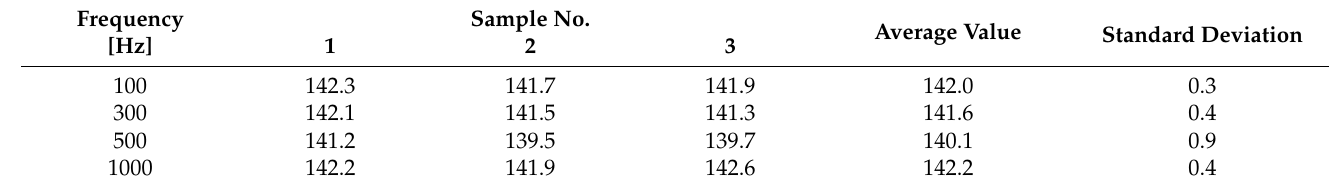
Table 10. Dynamic stiffness (dB re. 1 N/m) for PSMA8 poroelastic layer with SMA11 as binder course—laboratory measurements (L).